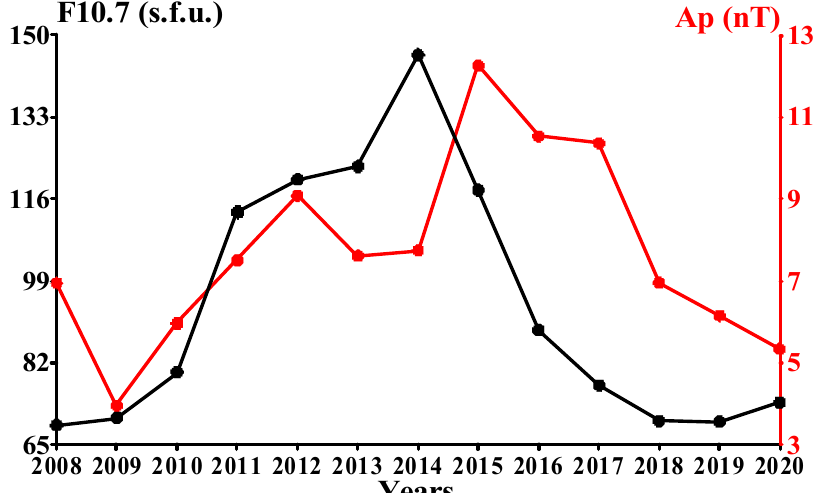
Figure 3. Year-to-year variations in the F10.7 (black) and Ap (red) indices.